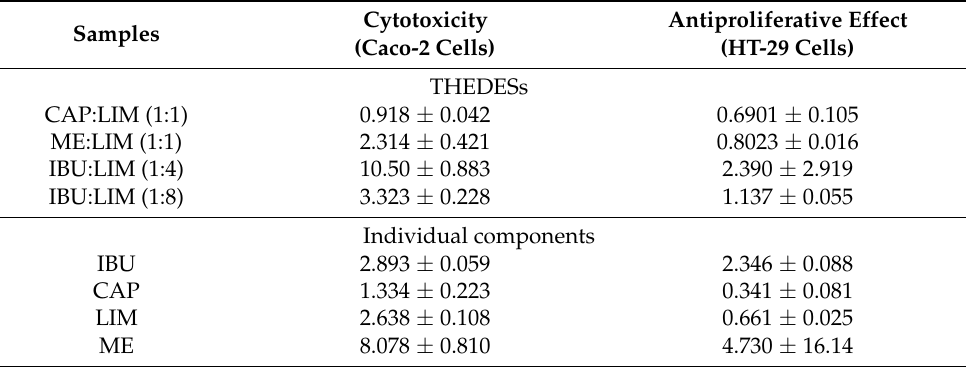
Table 5. EC 50 values (mM) for individual components and THEDESs in Caco-2 and HT-29 Cells, after an incubation period of 24